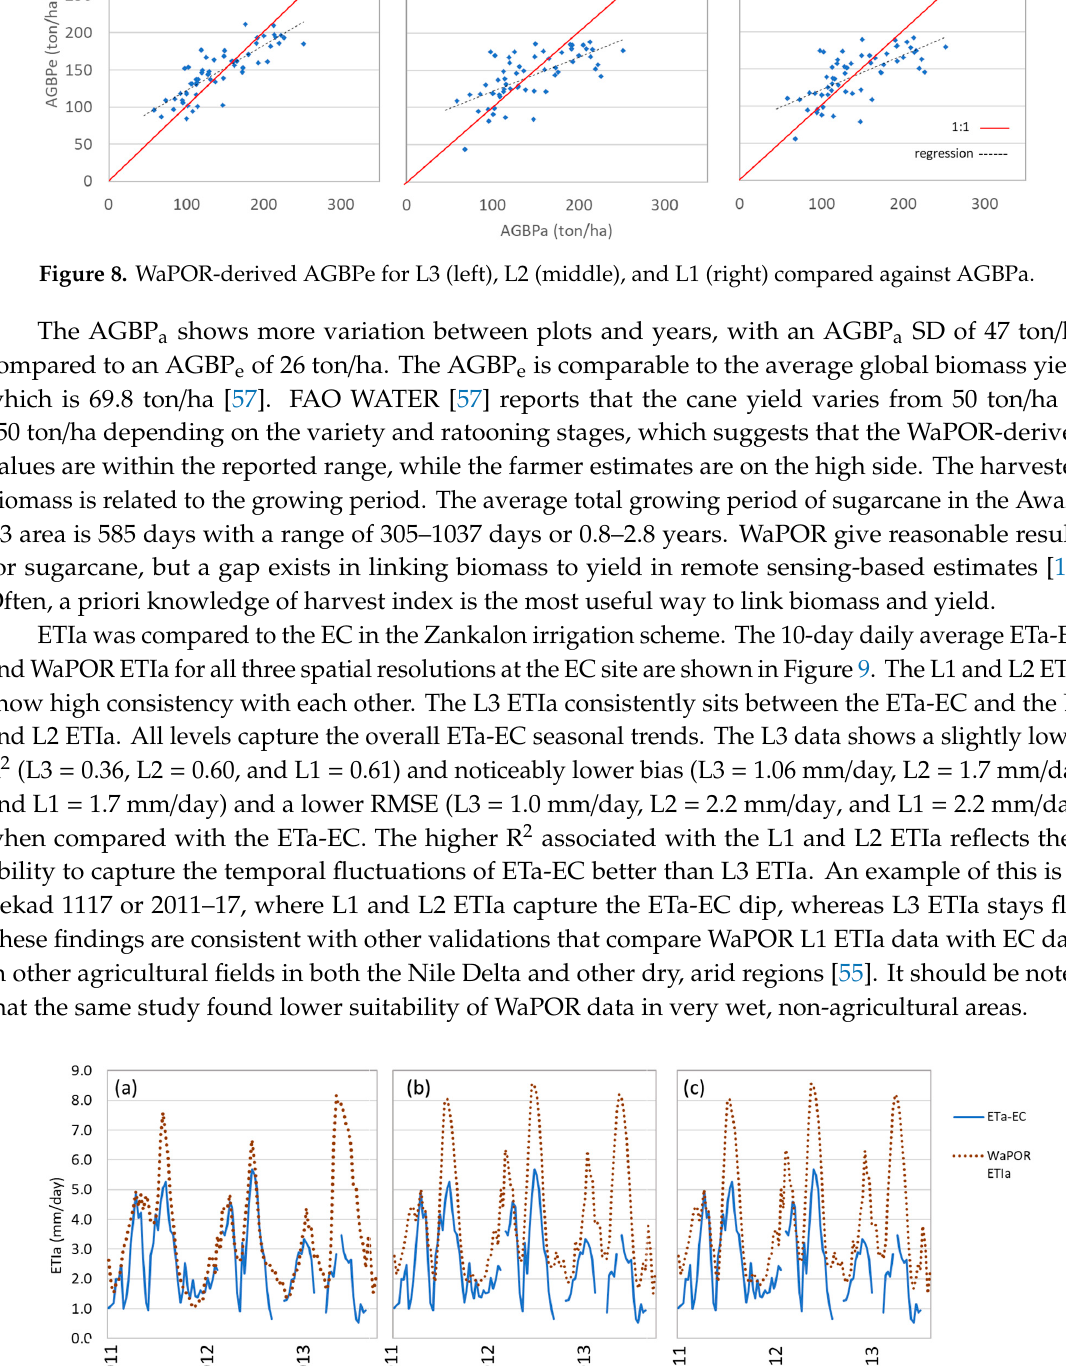
Figure 9. WaPOR dekadal ( a ) L3, ( b ) L2 and ( c ) L1 ETIa (mm/day) compared to in-situ dekadal ETa (mm/day).